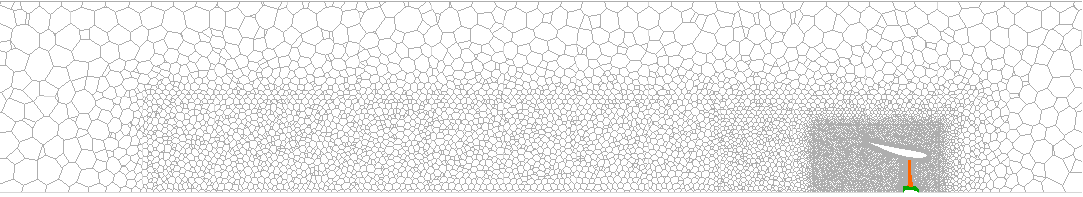
Figure 6. Mesh: Wake refinement.